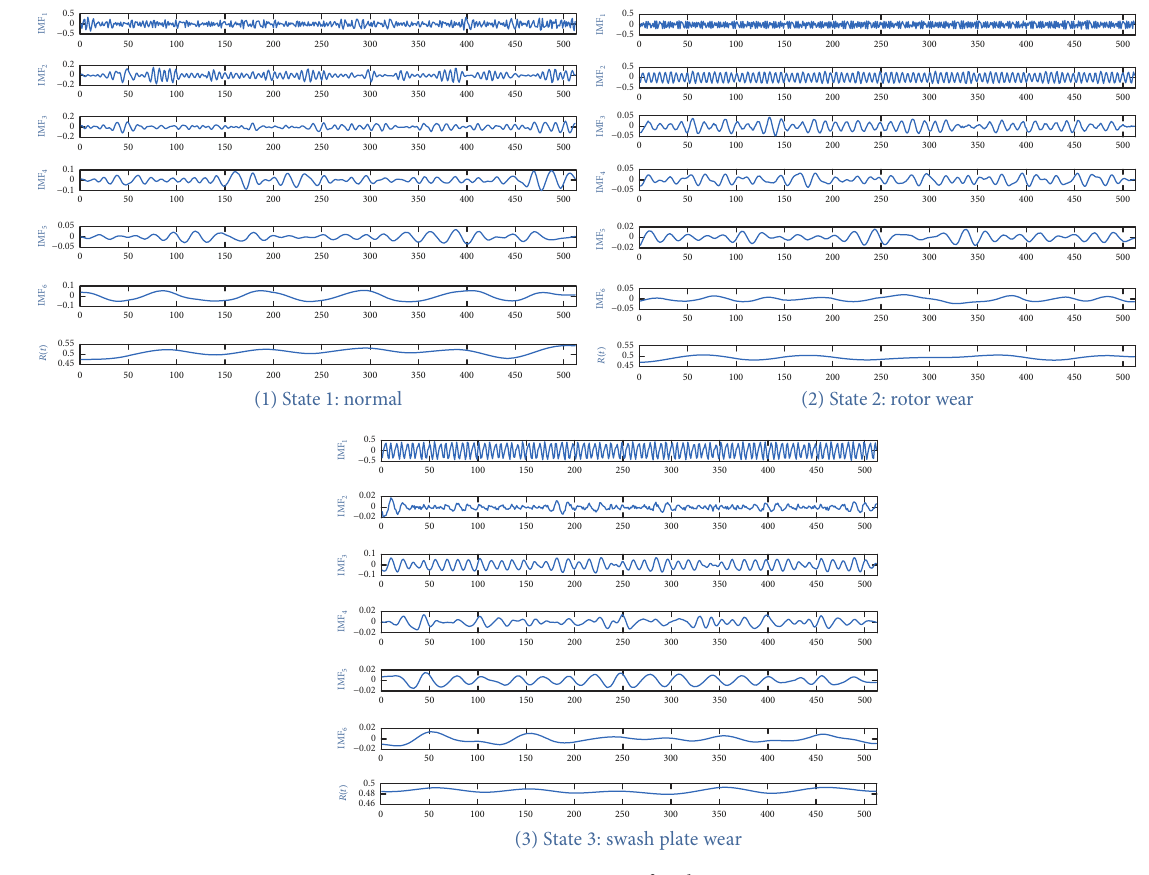
Figure 4: First 6 IMFs of each state.